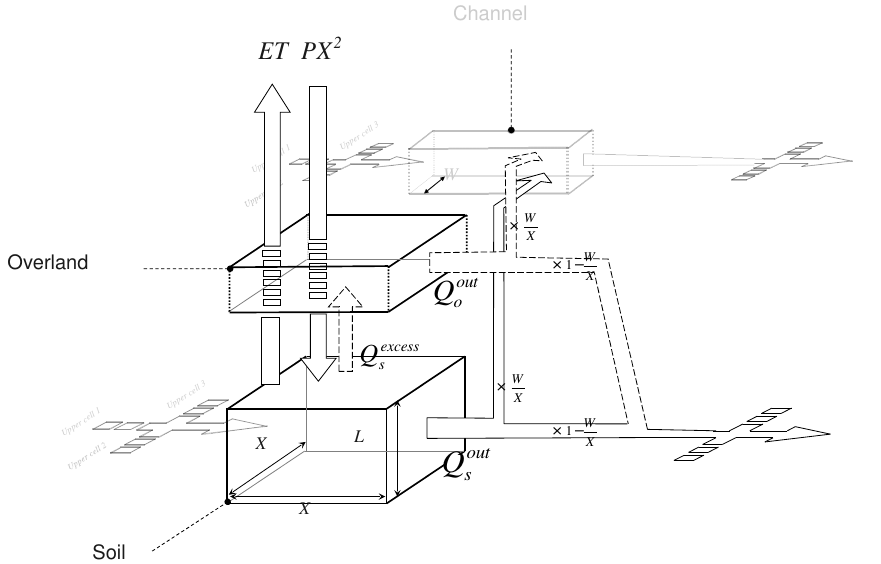
Fig. 7. A schematic representation of a typical TOPKAPI cell and the associated water transfers. Greyed out portions are not used in the pseudo-LSM mode. Adapted from Vischel et al.